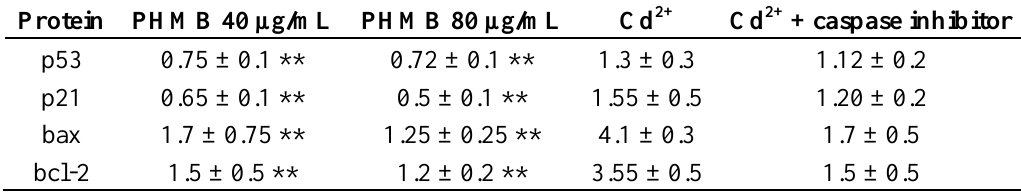
Table 10. Relative values of p53 , p21 , bax , bcl-2 proteins in Caco-2 cells incubated with PHMB for 24 h. Measurements were made using the Koma-ELISA kit (Japan). Plates were pretreated with anti-mouse antibodies. Values are expressed as mean ± SEM without unit.